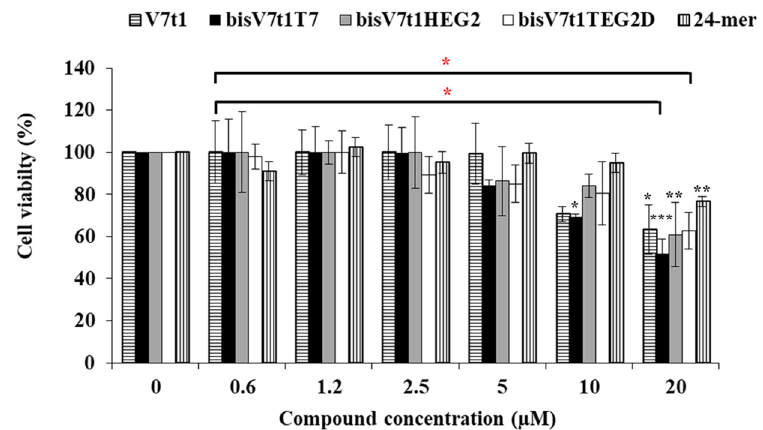
Figure 7. Cell viability assay of V7t1, bisV7t1T7 , bisV7t1HEG2 , bisV7t1TEG2D and a control 24-mer on MCF-7 cells tested by MTT assays. Cell viability is reported as the % of live cells with respect to control untreated cells (100% cell viability). Reported results derive from 4 independent experiments. Statistical analysis was performed by using Student’s t-Test by comparing all samples to the control cells (* P < 0.05, ** P < 0.01 or *** P < 0.001) and ANOVA test by comparing all covalent V7t1 dimers to V7t1 (* P < 0.05).